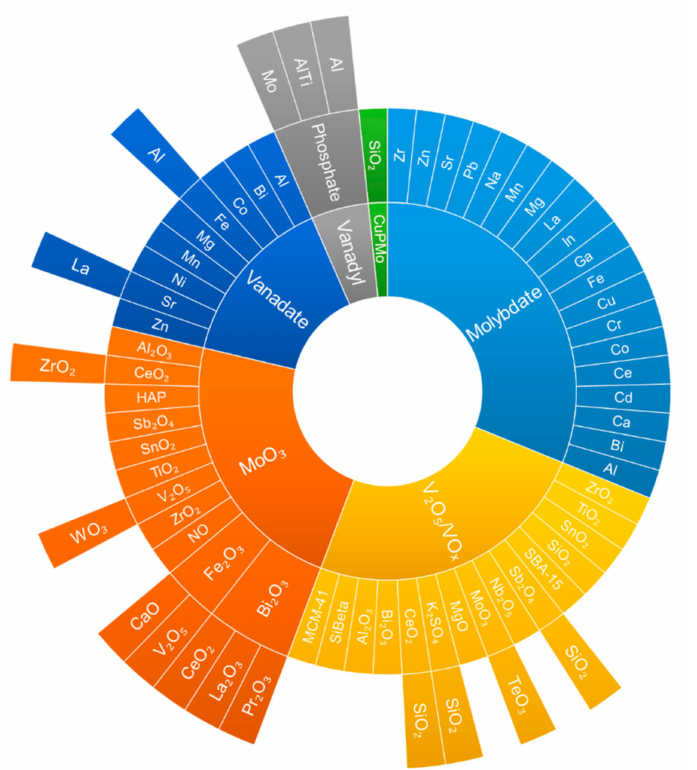
Figure 14. Solar plot for Mo and V containing catalysts showing main components (inner circle), secondary component or support material (middle circle), and tertiary component or support material (outer circle). Oxygen may be present without it being